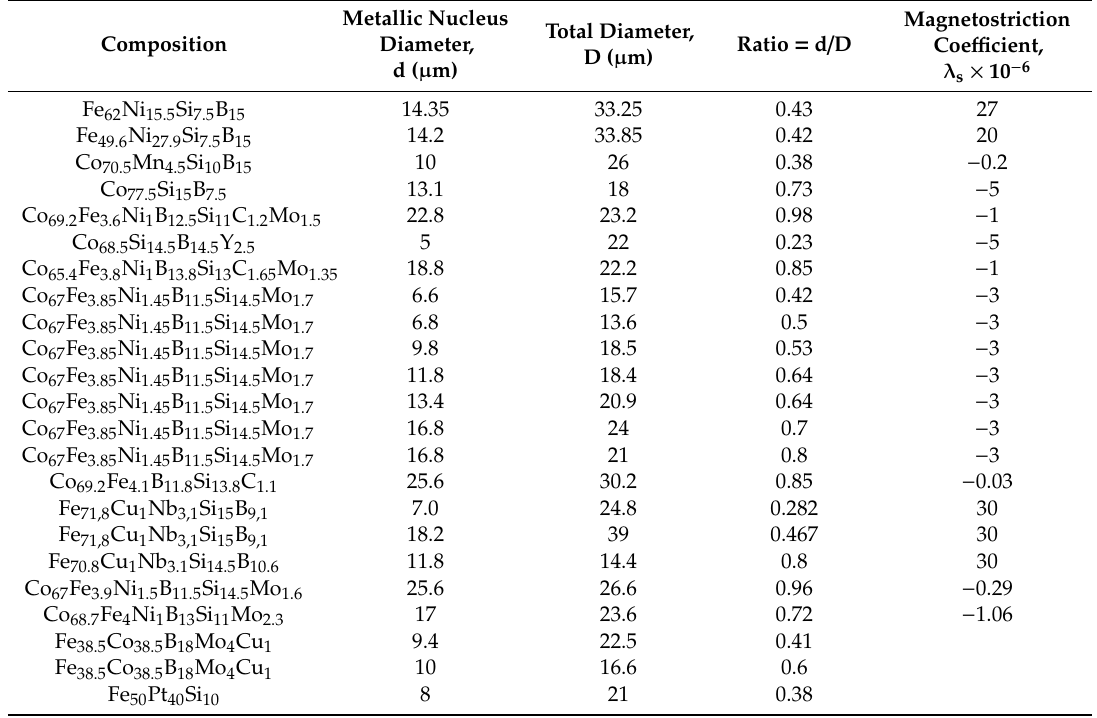
Table 1. Compositions and geometry of studied glass-coated microwires. Metallic Composition